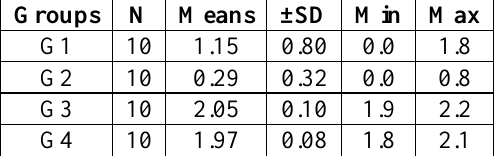
Table 2: Descriptive Statistics of all groups .